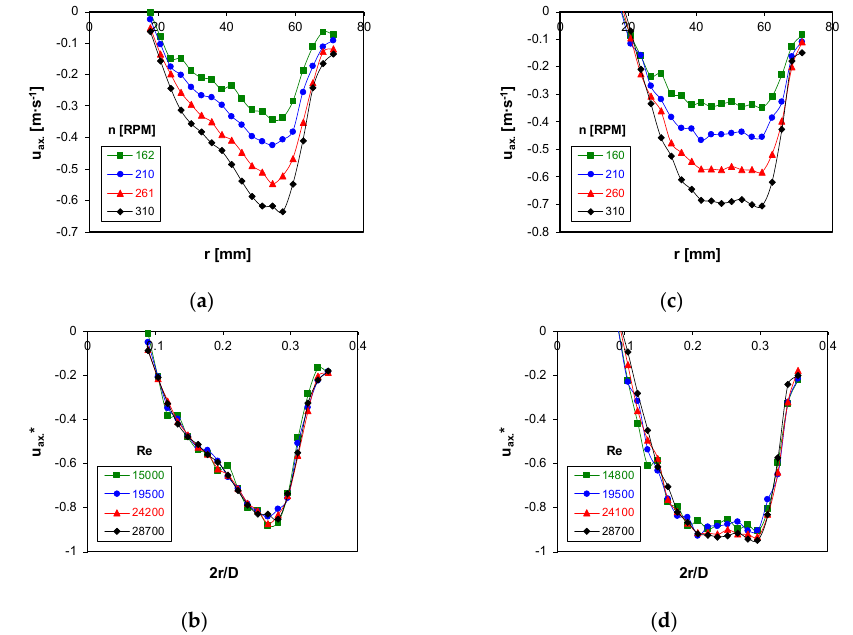
Figure 4. Axial velocity profile ( a , c ) and dimensionless axial velocity profile ( b , d ) of the liquid discharge from the rotor of the agitator: ( a , b ) 3SL24—pitched three-blade turbines with pitch angle 24°; ( c , d ) 3RLL—pitched there-blade turbine with diagonally folded blades [6].